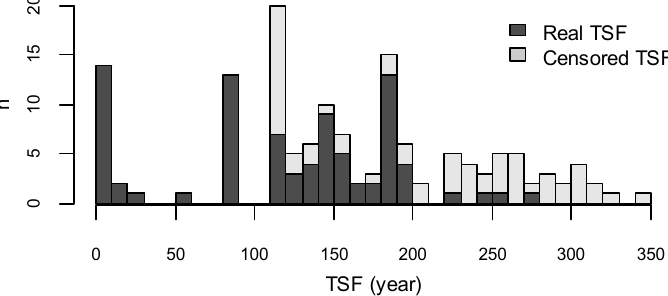
Figure 4. Real and censored (minimum) TSF distributions, grouped in 10-year age classes ( n = number of TSF data).